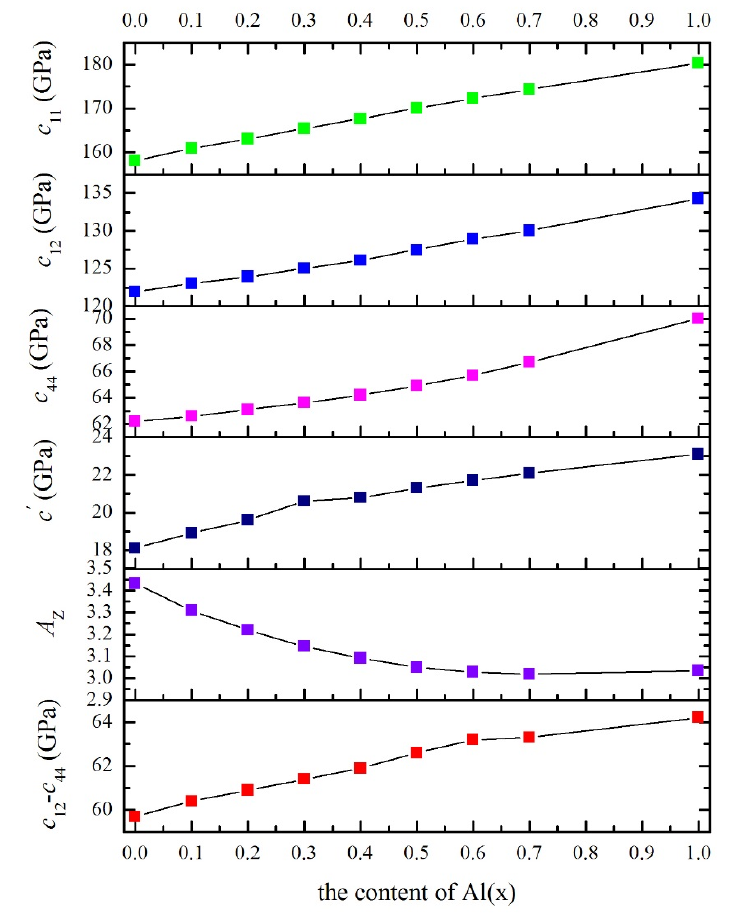
Figure 1. Theoretical elastic constants of Al x Hf 1 − x NbTaTiZr as a function of Al